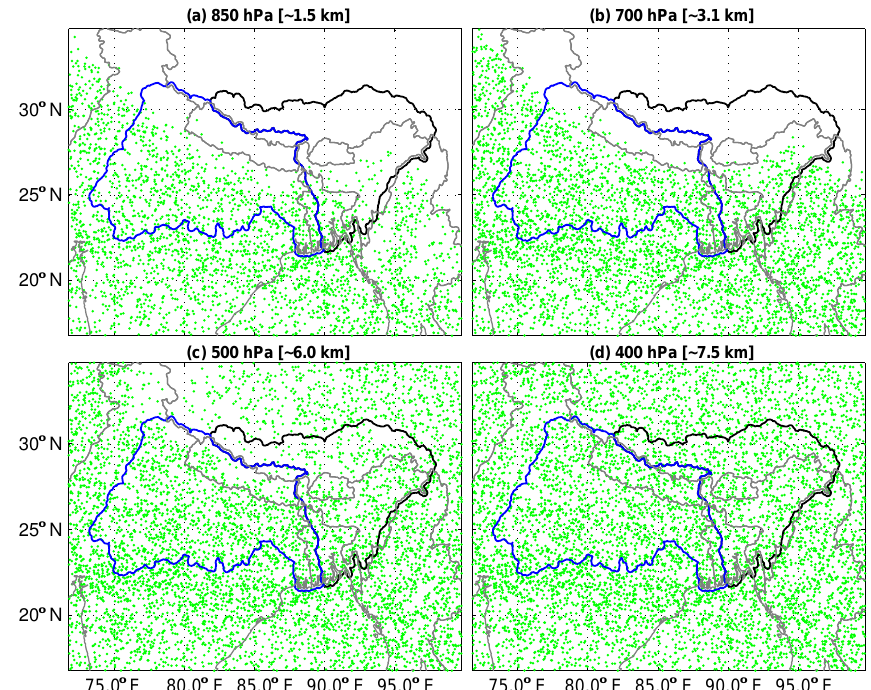
Figure 3. (a) Spatial distribution of COSMIC data points in the lower troposphere for the year 2012: (a) 850hPa ( ∼ 1 . 5km), (b) 700hPa ( ∼ 3 . 1km), (c) 500hPa ( ∼ 5 . 8km), and (d) 400hPa ( ∼ 7 .